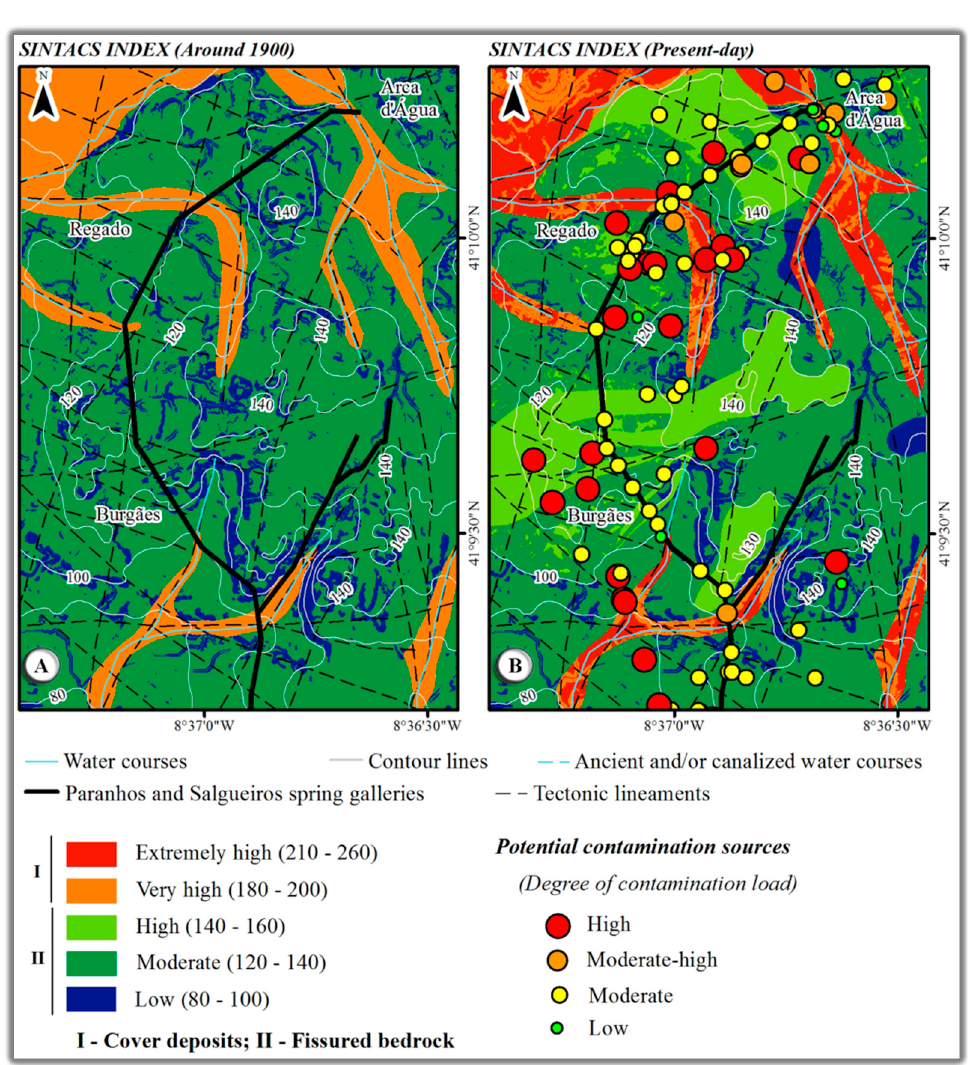
Figure 8. SINTACS vulnerability maps, and potential contamination sources for the present-day scenario.